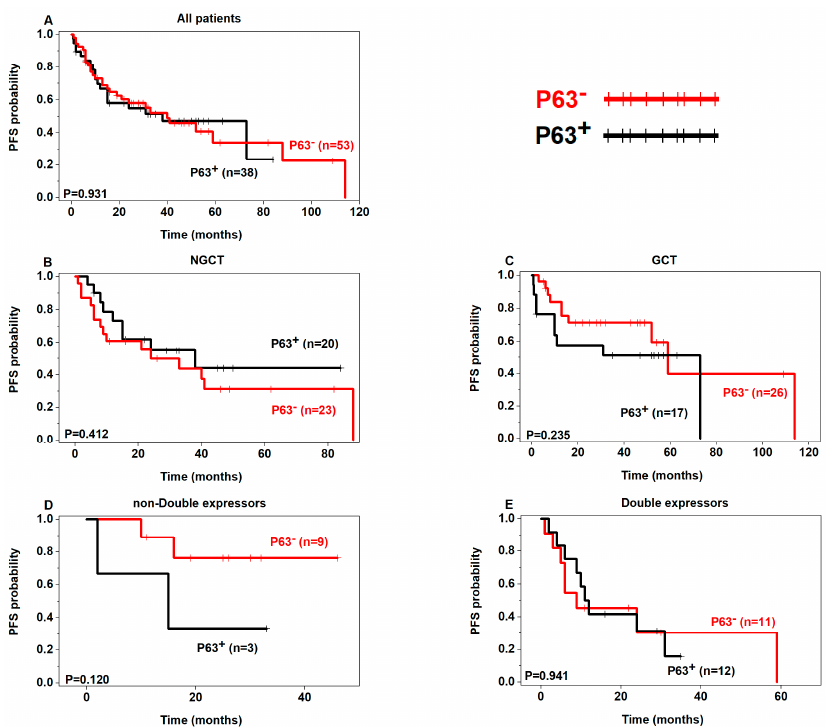
Figure 4. Prognostic analysis of p63 expression in DLBCL (OS) (p63+ in black, p63 − in red).